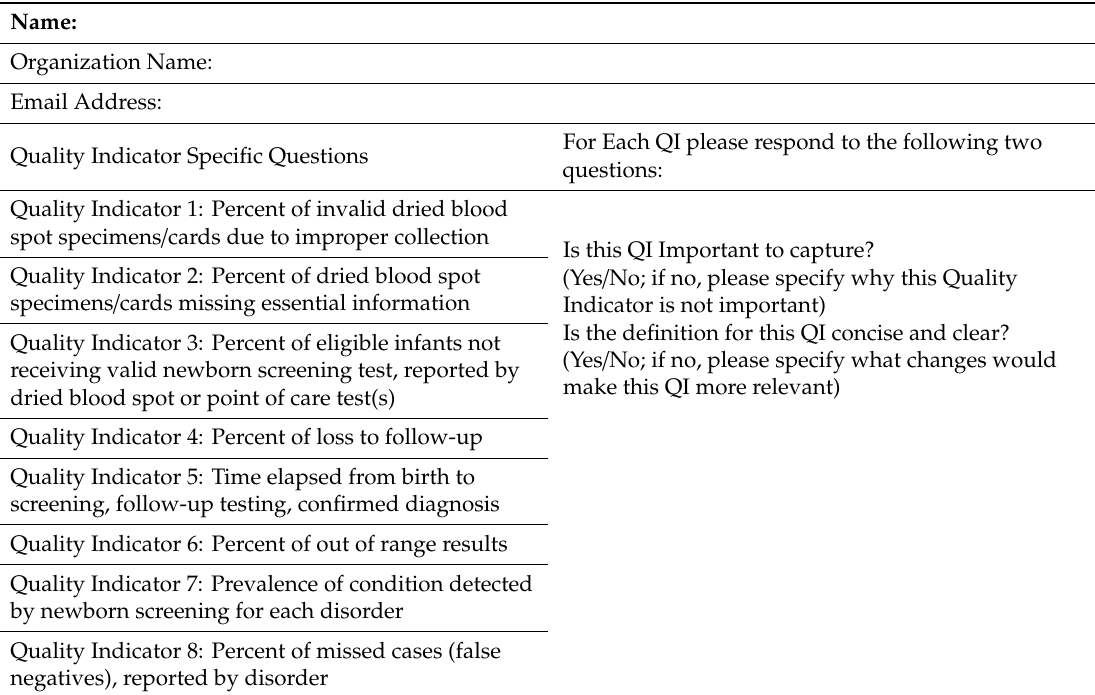
Table 5. Questions asked in the NewSTEPs Quality Indicator Survey (July